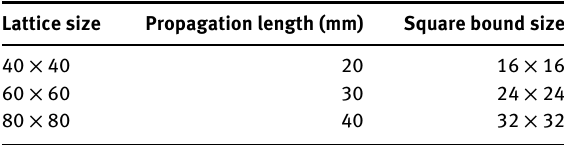
Table 1: Simulation parameters in different-sized